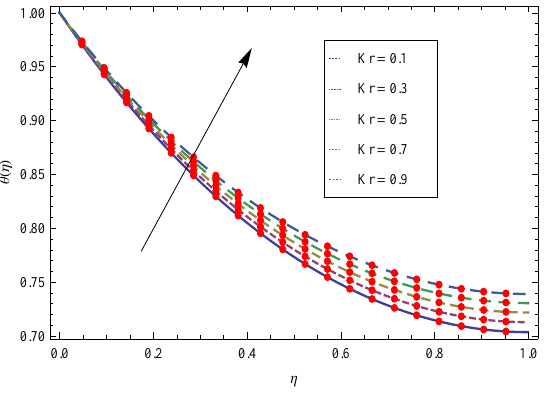
Figure 12. Shows the effect of Kr on θ ( η ) for h = − 0.25, λ = 0.1, S = 0.1,Pr = 0.5,Ec = 0.5, Nb = 0.5, Nt = 0.6 and Sc =